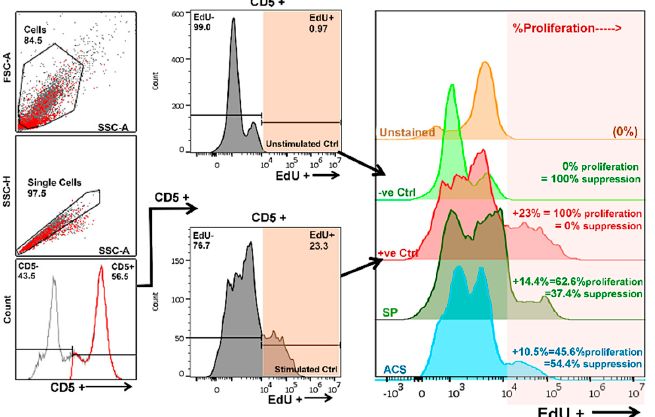
Figure 3. Flow cytometry gating and percentage of suppression calculation. The diagram shows the flow cytometric gating scheme. The EdU + cells in the CD5 + population were targeted. For each indi- vidual, the suppression percentage was calculated and normalized to their assay controls; unstim- ulated control (100% suppression) and stimulated control (0% suppression). The image shows the calculation of a representative dog. Abbreviations, CD; Cluster of differentiation, FSC; Forward scat- ter, SSC; Side scatter, EdU; 5-ethynyl-2 ′ -deoxyuridine, Ctrl; Control, ACS; Autologous conditioned serum, SP; Sham plasma.